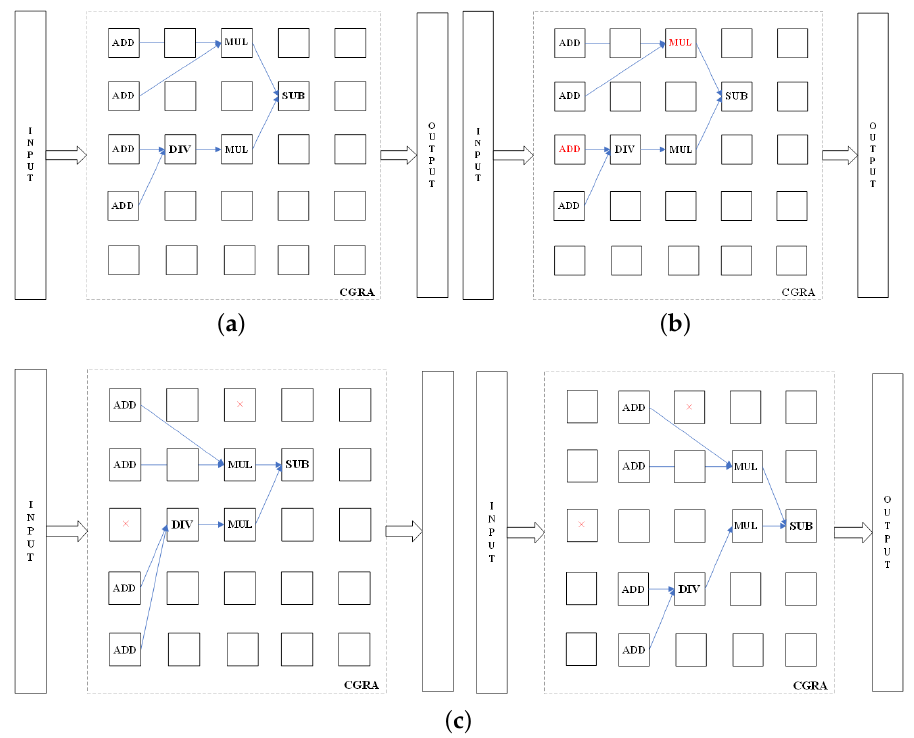
Figure 8. Description of the example circuit-II and anticipation of the HT mitigation mechanism. ( a ) original circuit-II. ( b ) HT inserted in the circuit-II. ( c ) EA-based reconfiguration to correct the circuit-II. (Red mark: the HT-I PEs; Blue Arrow: The data